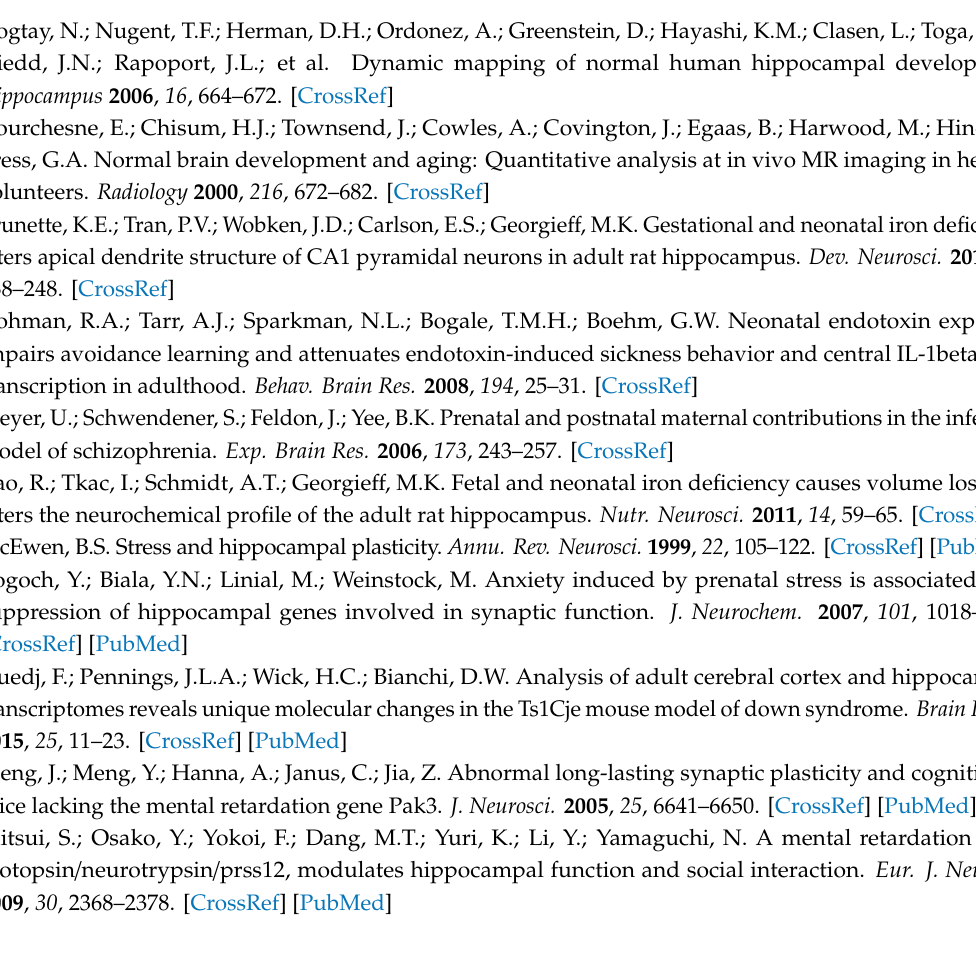
Supplementary Materials: The following are available online at http: // www.mdpi.com / 2073-4425 / 11 / 2 / 162 / s1, Figure S1: Distribution of methylation